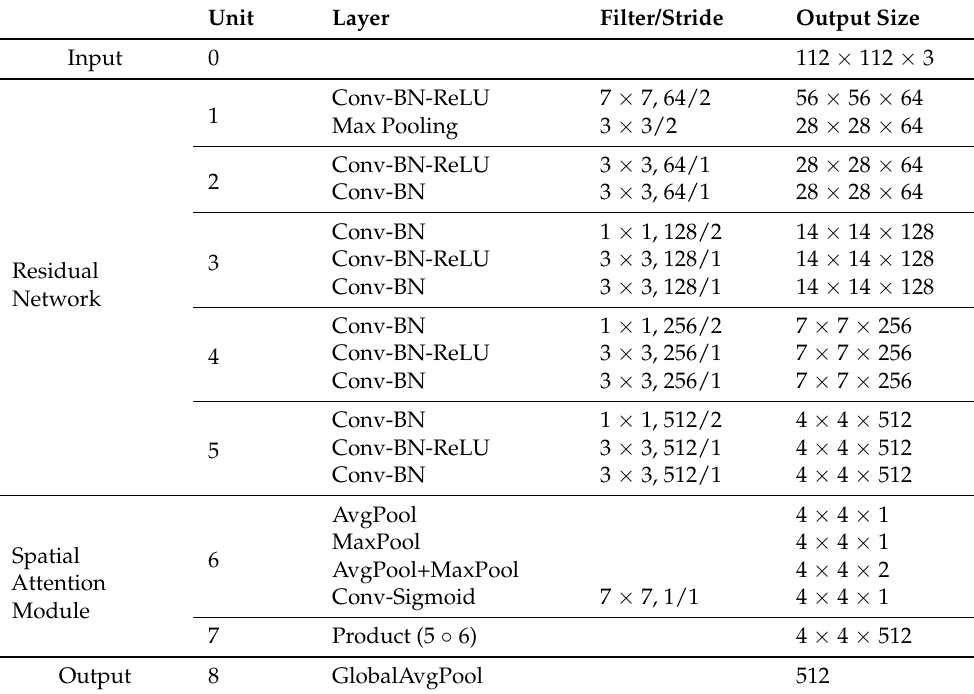
Table 2. Network structure of the residual network and spatial attention module.